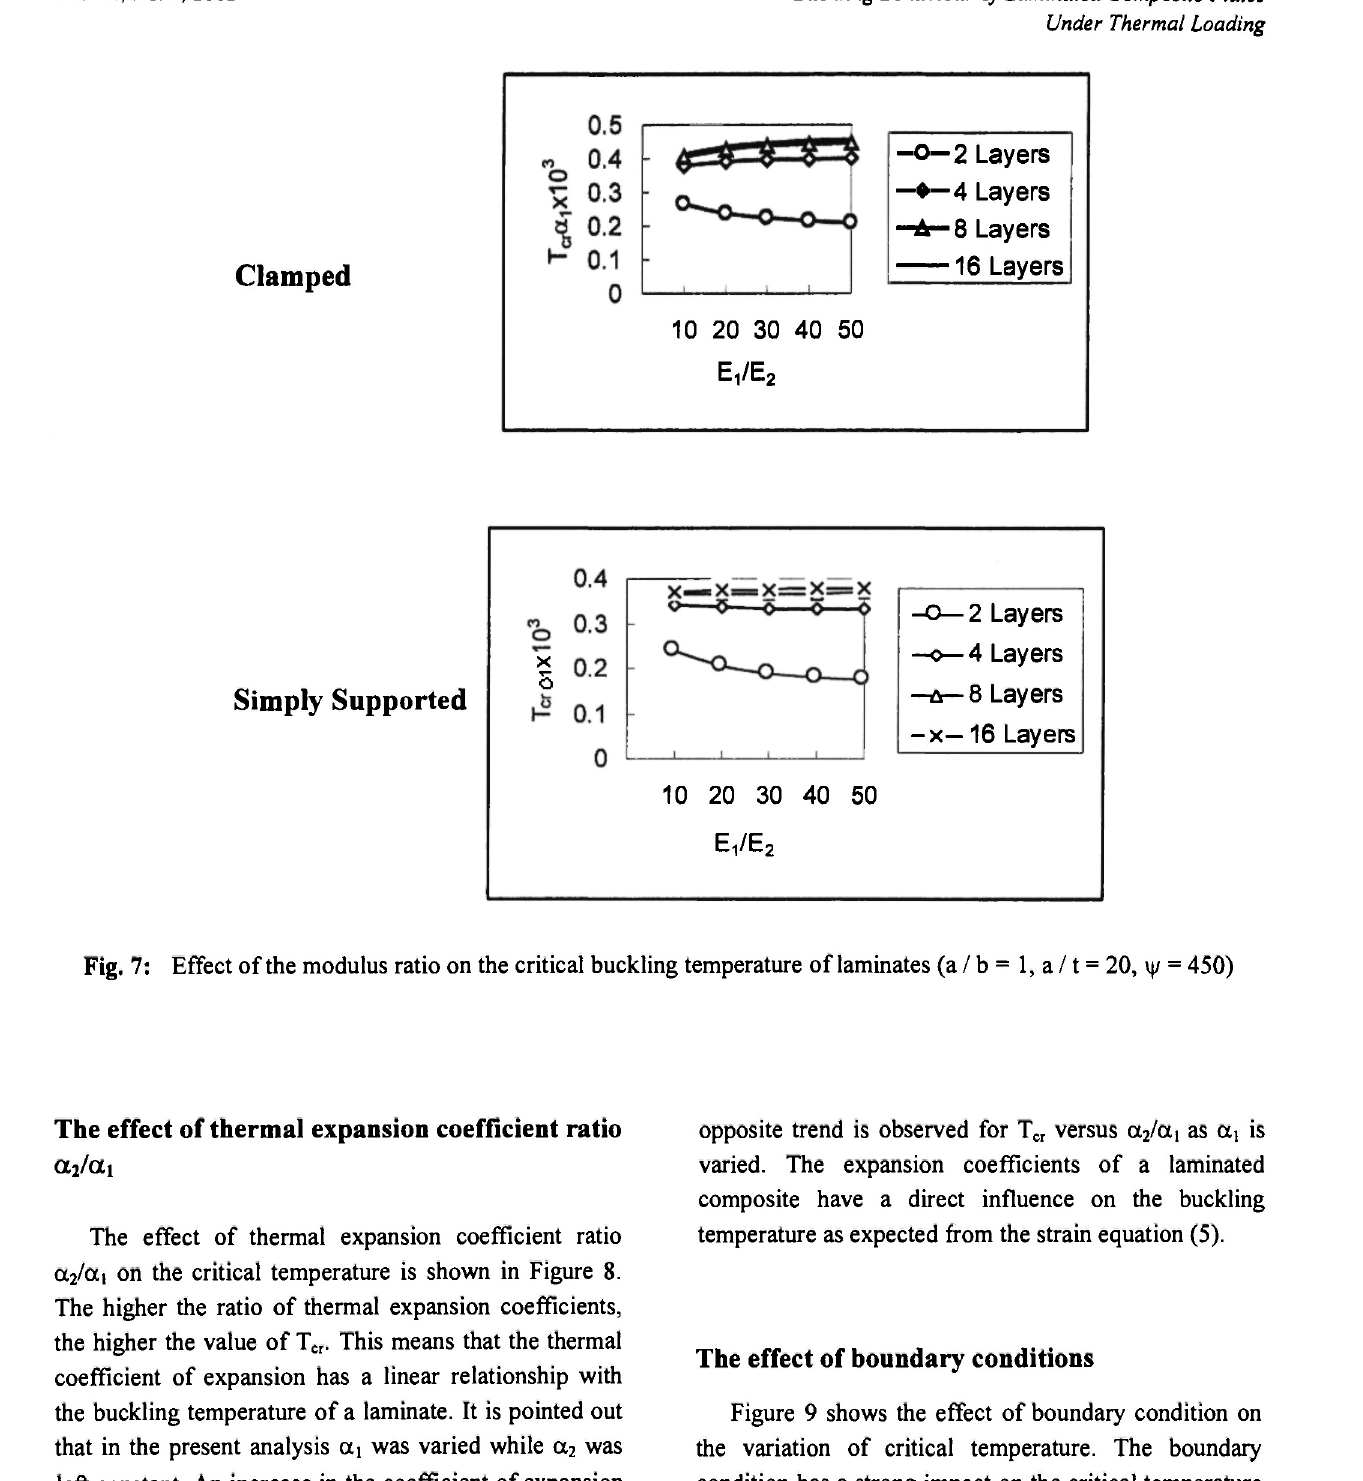
The effect of thermal expansion coefficient